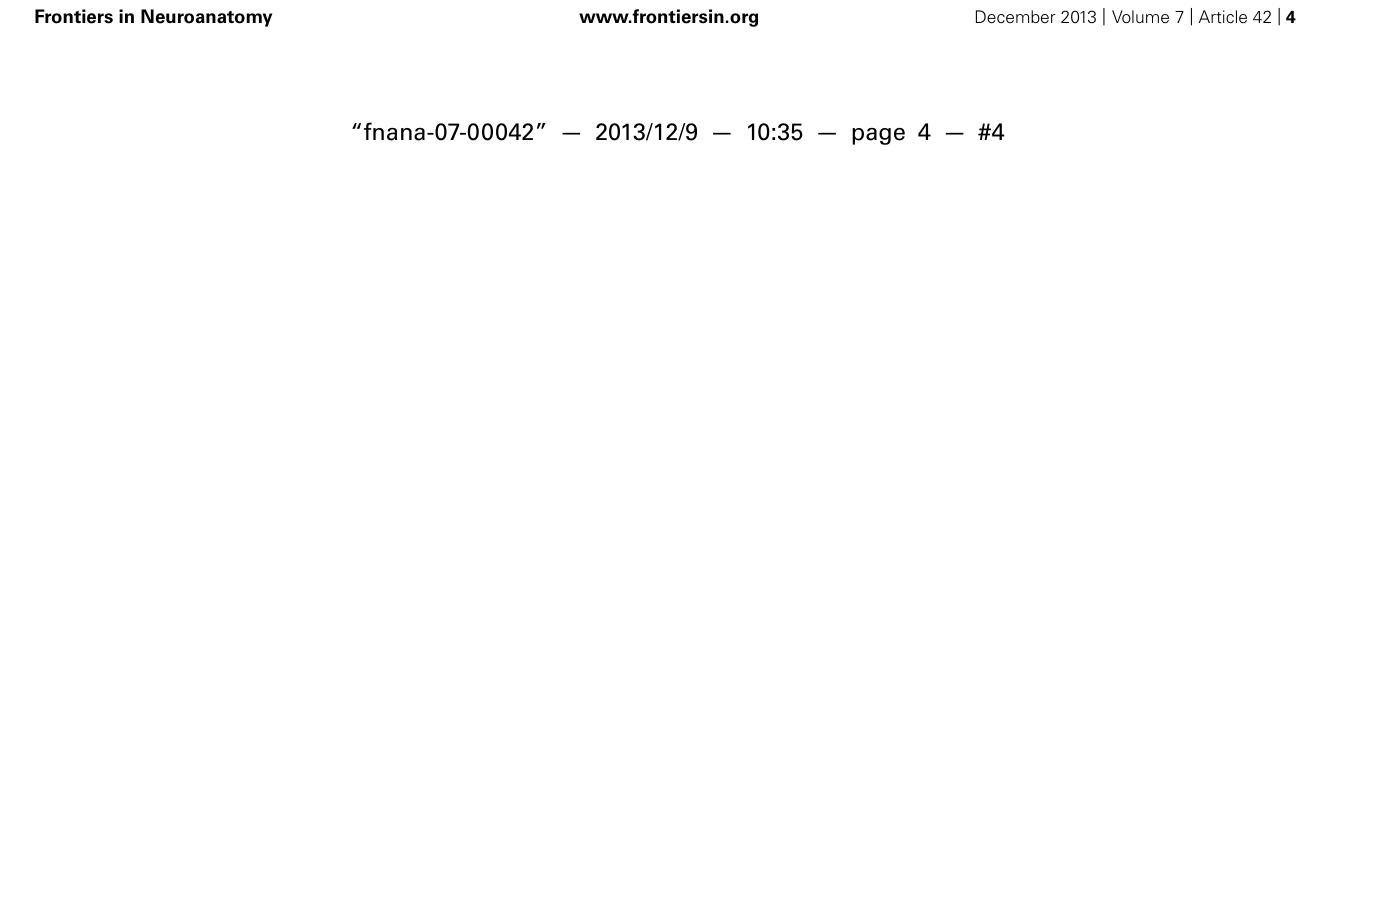
few GABAergic neurons were labeled with BrdU as early as E10.5 ( Figure 3B ). The number of GFP + /BrdU + cells following BrdU injection at E11.5 was remarkably increased compared to that at E10.5, accounting for nearly 37.1 (32.18–41.98)% of the